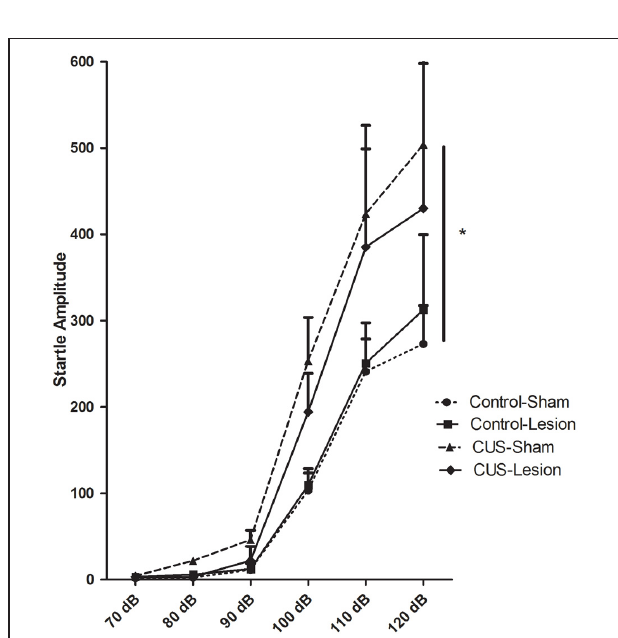
FIGURE 5 | Acoustic startle responses. Startle amplitude in response to an acoustic stimulus. CUS induces an increase in the startle when comparing with controls. CUS, chronic unpredictable stress; ∗ p < 0 . 05. Results are presented as mean ± SEM.